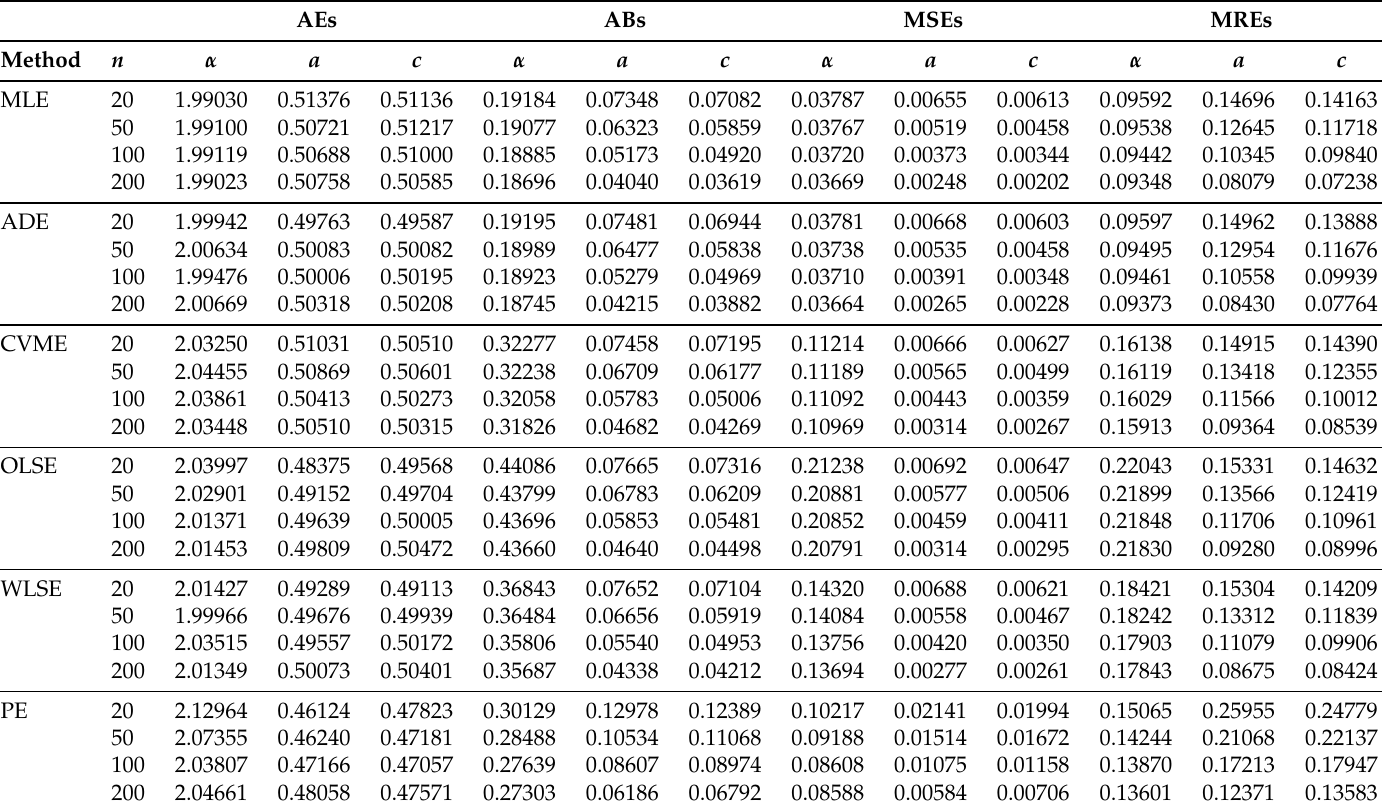
Table A2. The AEs, ABs, MSEs, and MREs for ( α = 2, a = 0.5, c = 0.5 )